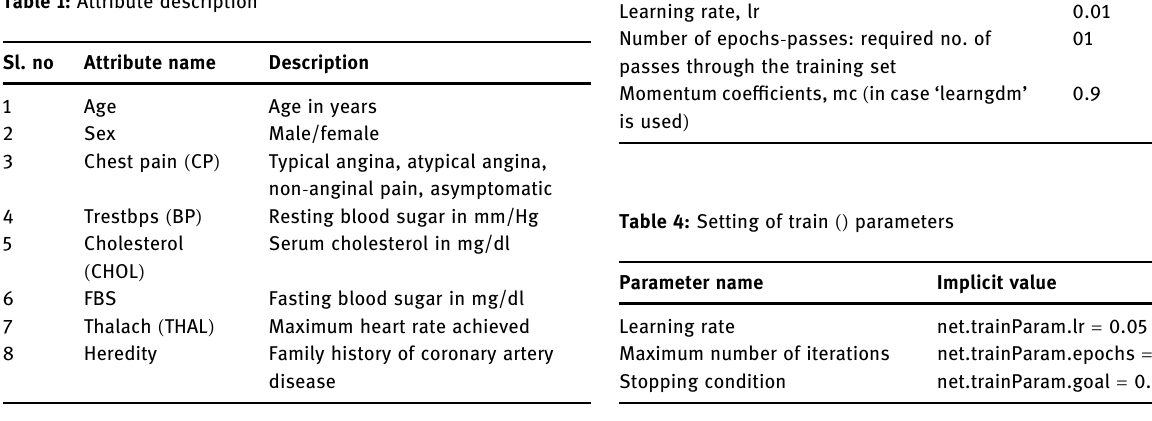
Table 1: Attribute description